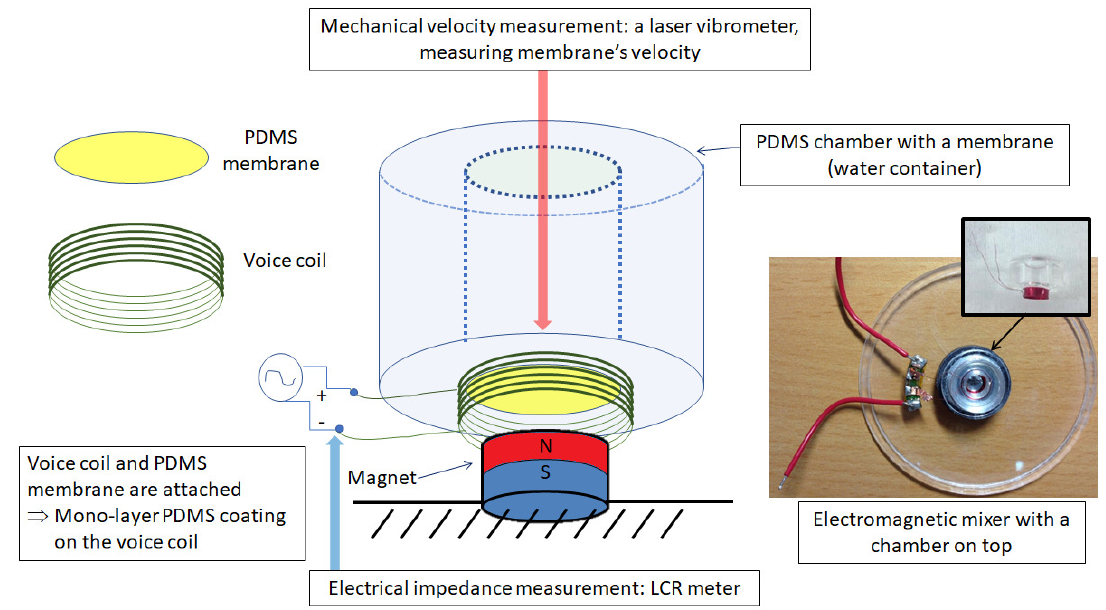
Figure 3. A schematic illustration and a picture to explain the experimental concept. The signal (i.e., sweep frequencies generated by a function generator) is applied to the coil’s terminals. Then, due to the permanent magnet, the electromagnetic force drives the coil to move. An LCR meter is used to take the electrical driving point impedance of the system, and a laser vibrometer light is focused on the membrane to measure the membrane’s